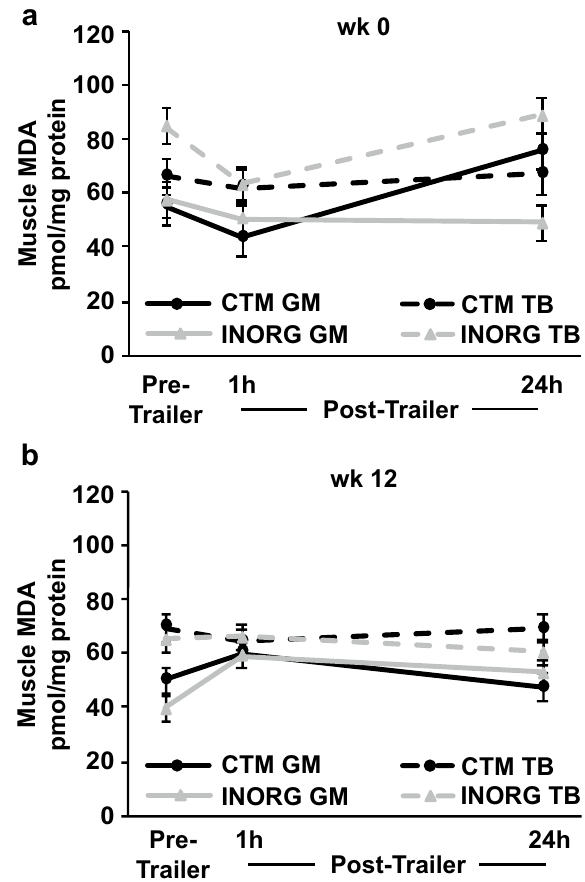
Figure 1. Muscle malondialdehyde (MDA) concentration before (Pre-Trailer), and 1 (1 h) and 24 h (24 h) after a 1.5-h trailer stressor. Trailer stressors occurred before (week 0; a ) and after (week 12; b ) 12 weeks of submaximal exercise training in yearling horses supplemented with either complexed trace minerals (CTM; n = 8) or inorganic trace minerals (INORG; n = 8). Overall effect of diet ( P = 0.306; P = 0.226), trailering ( P = 0.011; P = 0.172), muscle group ( P < 0.0001; P < 0.0001), diet × trailering ( P = 0.258; P = 0.596), diet × muscle group ( P = 0.014; P = 0.945), time × muscle group ( P = 0.840; P = 0.119) and diet × time × muscle group ( P = 0.071; P = 0.450) for panels a and b